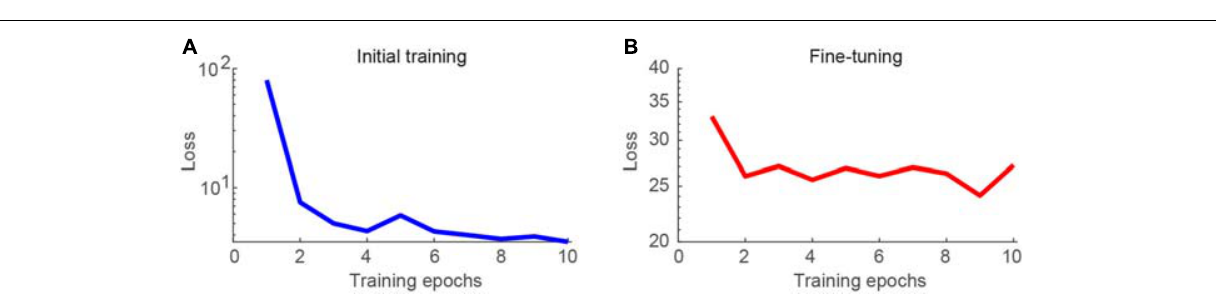
FIGURE 1 | Schematic illustration of the neural network for model blind spatiotemporal denoising. The neural network trained using the synthesized noisy imaging dataset can be fine-tuned to analyze the real two-photon imaging dataset by noise-to-noise learning. Conv, 2D convolutional layer; LReLU, leaky rectified linear unit.